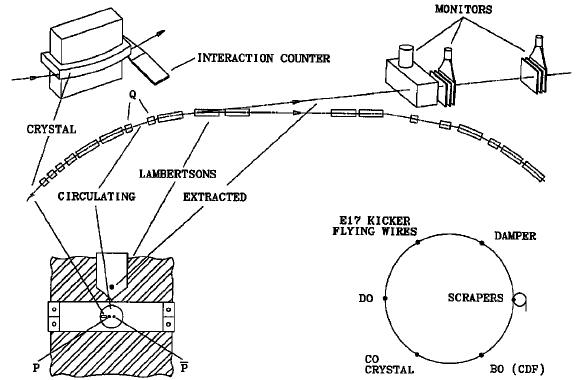
FIG. 1. Schematic of the channeling extraction apparatus. The bent crystal deflects protons up through the quadrupoles into the field-free region of the Lambertson magnets. The protons are detected with a system of scintillators in two air gaps separated by 40 m. The inset shows the location of the crystal extraction system, the fast kicker, the RF damper, and the collider experiments at B0 (CDF) and D0.